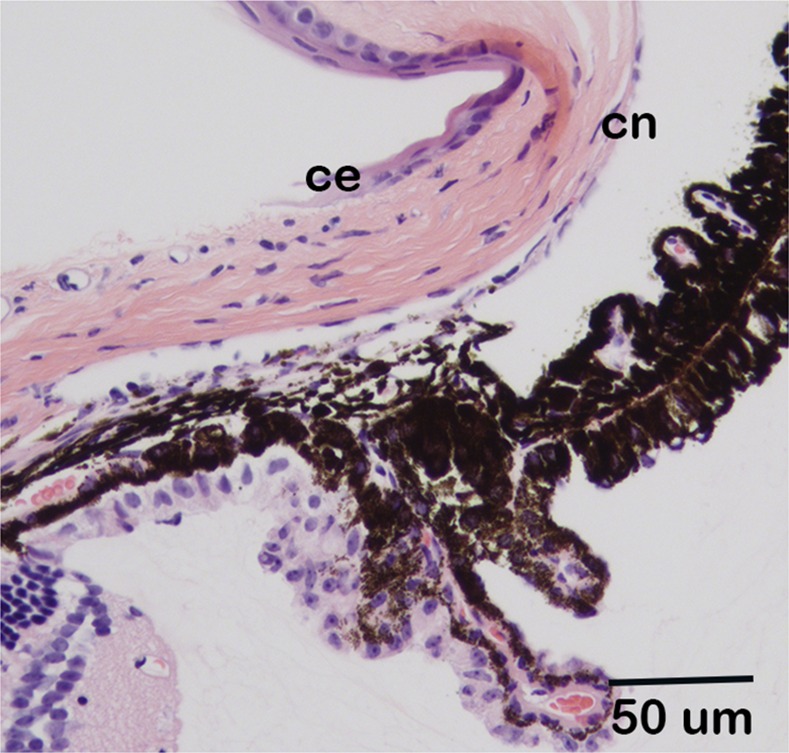
Normal appearance of the iridocorneal angle of Csrp2bpEx/ Dzank1tm1a double heterozygous mice.Csrp2bpEx/ Dzank1tm1a double heterozygote, age 5 months, H&E. ce, corneal epithelium; cn, corneal endothelium.